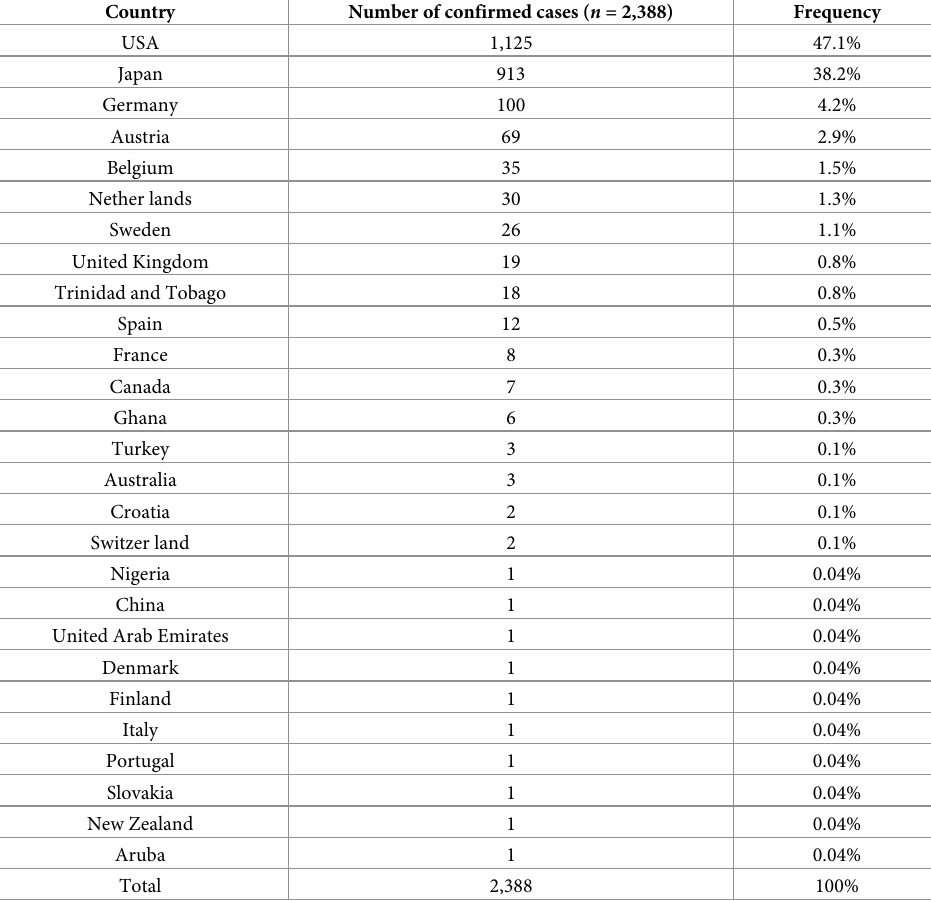
Table 2. Global numbers and percentages of confirmed R.1 lineage SARS-CoV-2 cases.